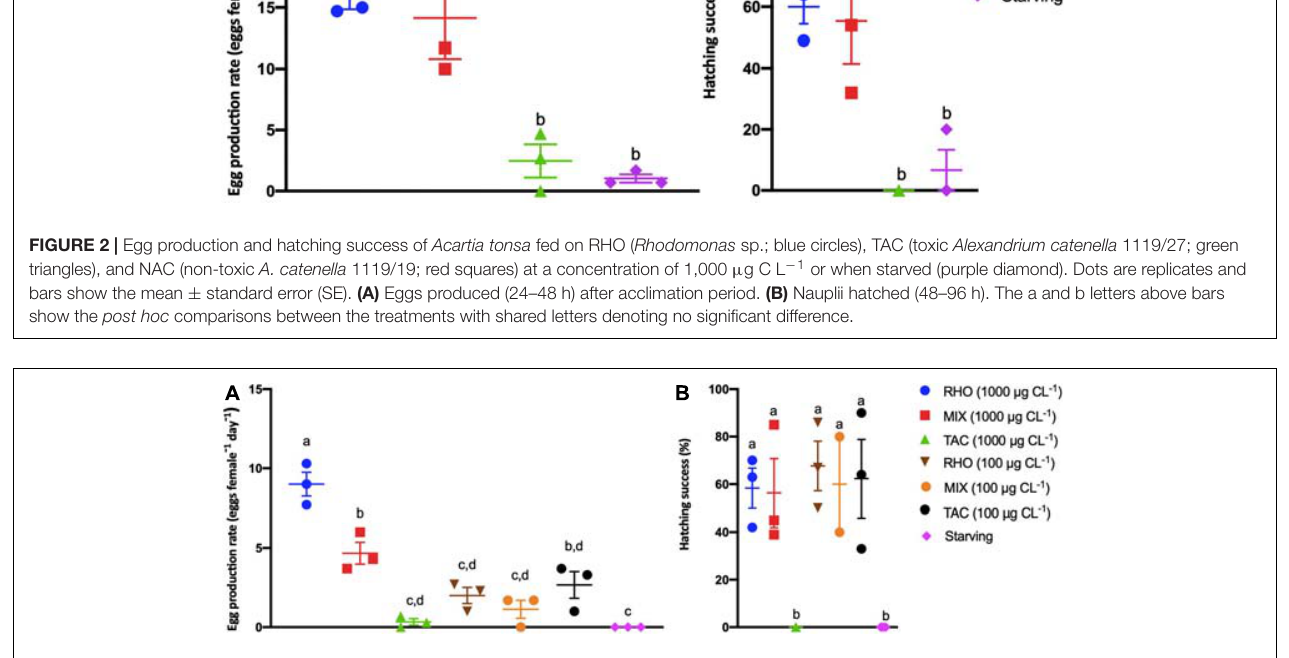
FIGURE 3 | Egg production and hatching success of Acartia tonsa fed on RHO ( Rhodomonas sp.; brown inverted triangles and blue circles, 100 and 1,000 µ g C L − 1 , respectively), TAC (toxic Alexandrium catenella 1119/27; black circles and green triangles, 100 and 1,000 µ g C L − 1 , respectively), and MIX (50:50 mixture of both cell types, orange circles and red squares, 100 and 1,000 µ g C L − 1 , respectively) at two concentrations: 100 and 1,000 µ g C L − 1 or when starved (purple diamond). The dots are replicates, and bars show the mean ± standard error (SE). (A) Eggs produced (24–48 h) after acclimation period. (B) Nauplii hatched (48–96 h). The a and b letters above bars show the post hoc comparisons between the treatments with shared letters denoting no significant